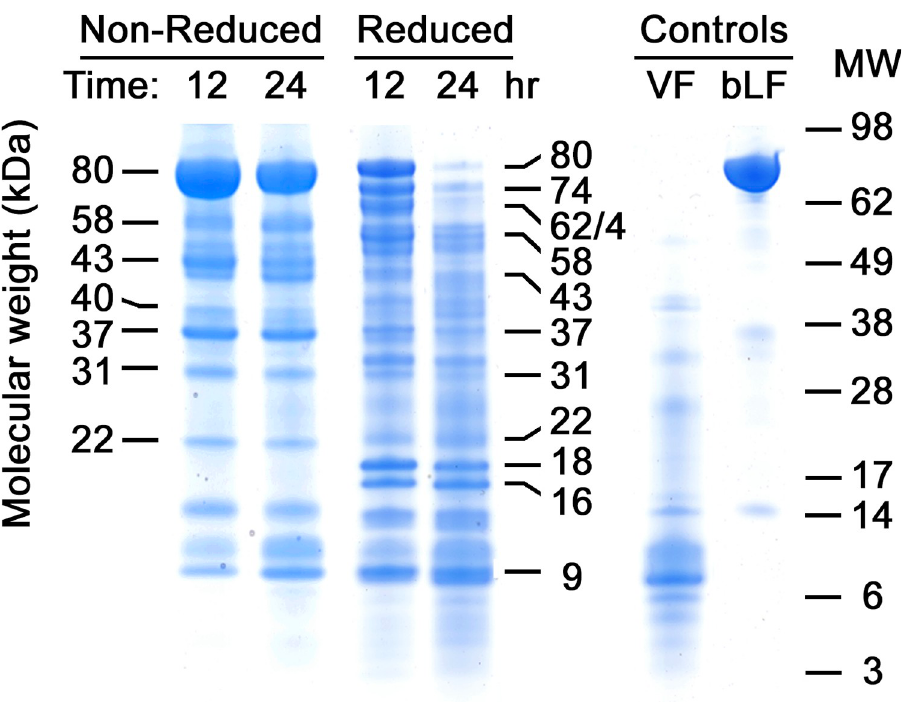
Fig 1. Fragmentation of bLF in human vaginal fluid. Characteristic patterns of fragments developed when MTbLF was dosed intravaginally in an individual clinical subject and followed over time. On the left, samples from two time points, 12 and 24 hr post dose, are shown without reduction, preserving disulfide bonds. Identical samples are shown in the next two lanes, after reduction to break disulfide bonds revealing nicked fragments present in the 80 kDa forms on the left. At right, control samples are shown, including the subject’s VF with no bLF present and intact MTbLF before dosing, in their reduced forms. The numbers on the left and mid-right identify the molecular weights of fragments that we repeatedly detected in VF samples from many, but not all, clinical subjects dosed with MTbLF. The bLF control lane was loaded with 5 μ g of MTbLF. Numbers at far right represent SeeBlue-Plus-2 standard proteins run on the same PAGE gels as the